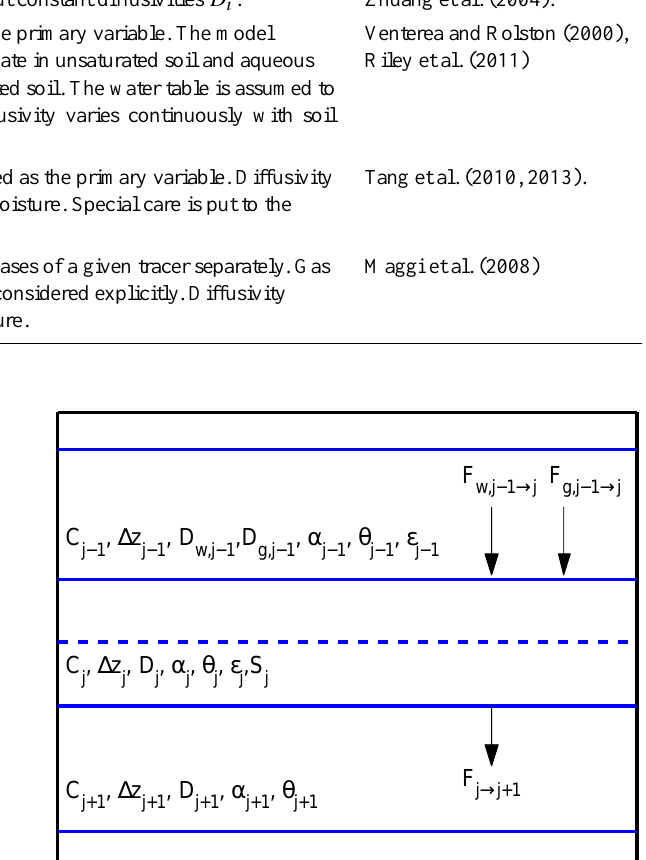
Riley et al. (2011) Tang et al. (2010, 2013).